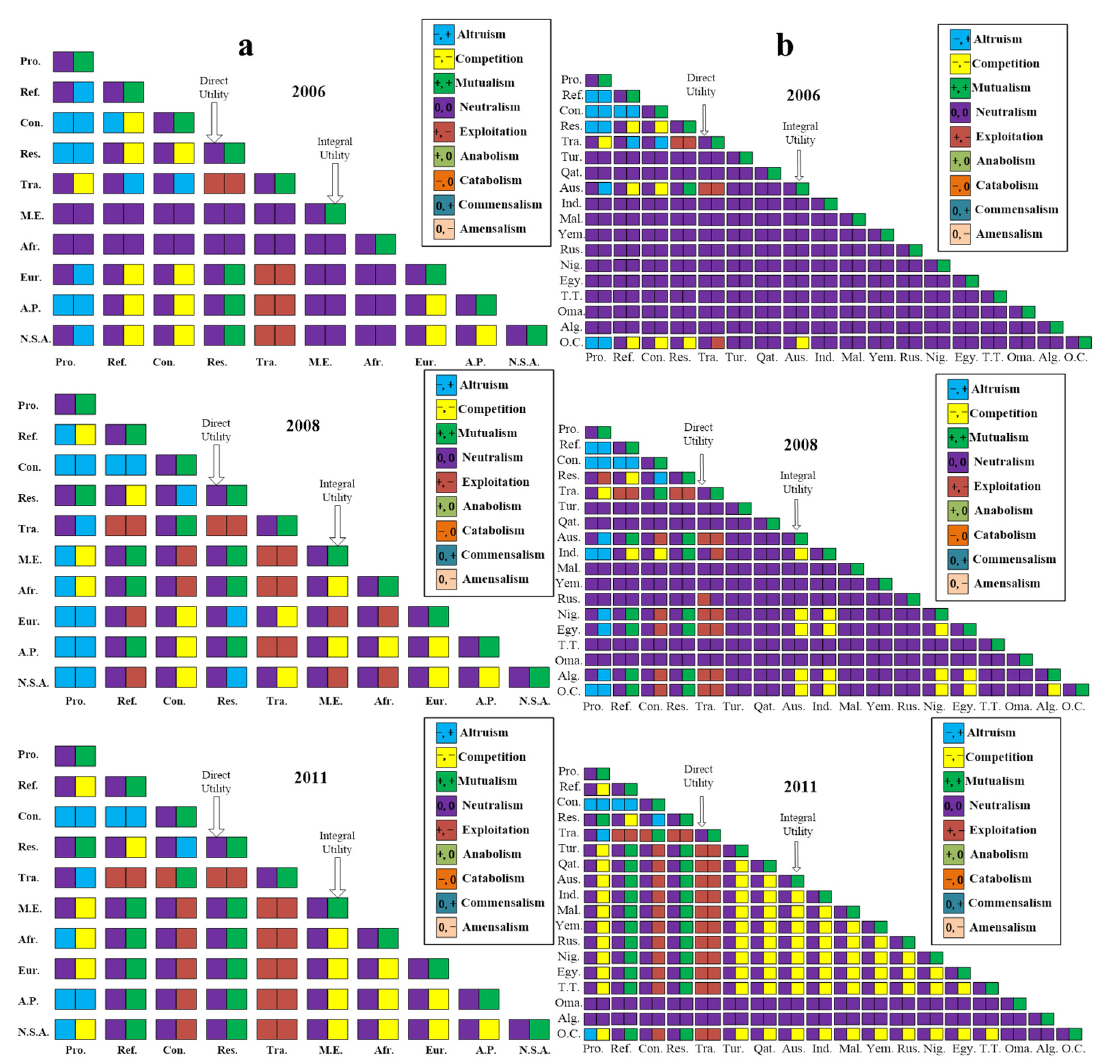
Figure 8. Direct and integral utility of China’s natural gas supply system in 2006, 2008, and 2011 based on network models on: ( a ) the RL and ( b ) the NL. Mutual relationships between two sectors are shown in different colors, whose direct and integral utilities were also isolated in two boxes. Pro.: